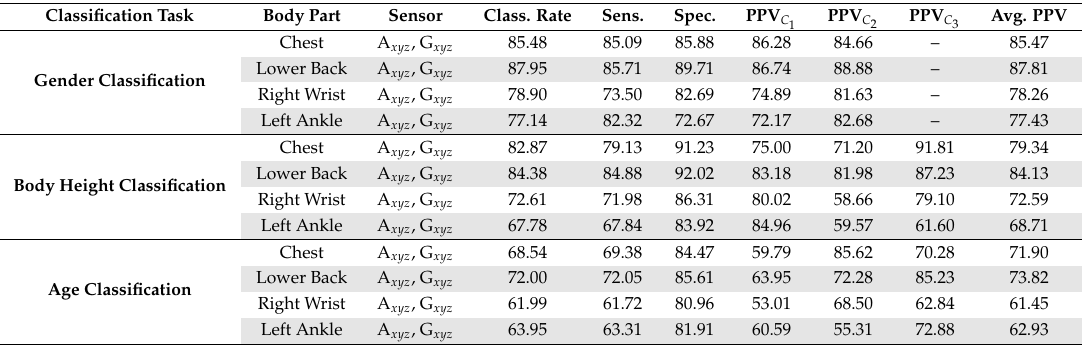
Table 11. Subject-wise classification results of different classification categories: gender, height and age. The results show balanced correct classification rates, sensitivity, specificity, the positive predictive value (PPV) of each class and the average PPV of all